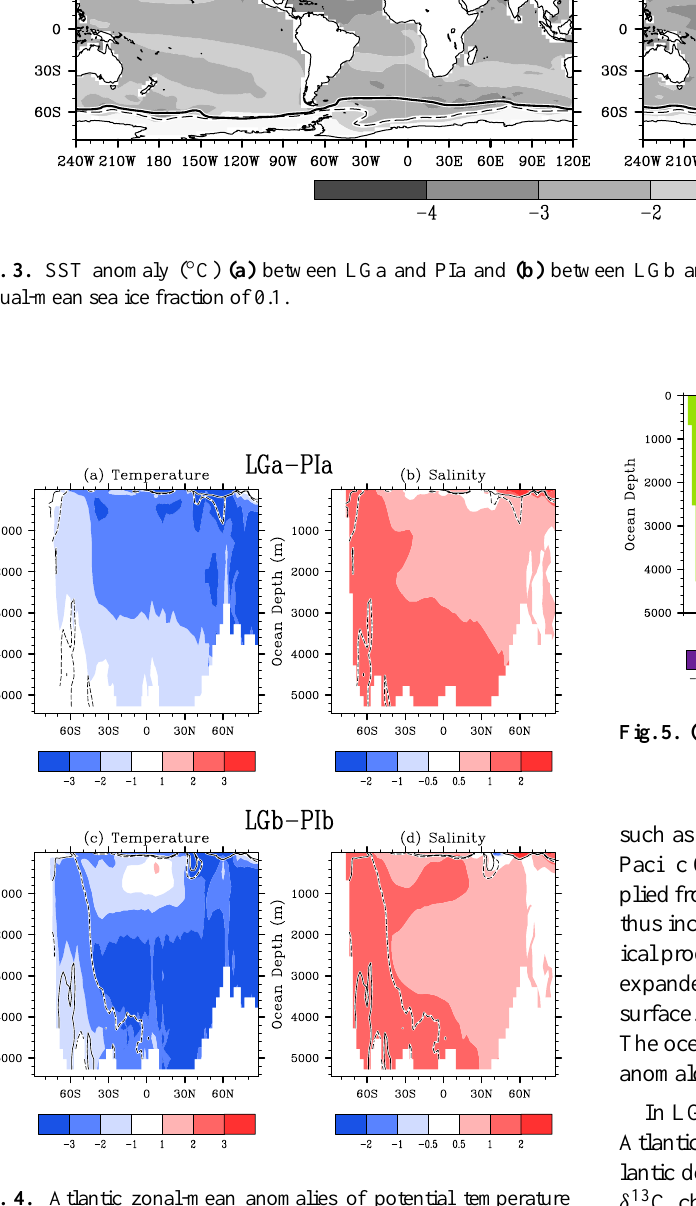
Fig. 4. Atlantic zonal-mean anomalies of potential temperature ( ◦ C) and salinity (psu) (a and b) between LGa and PIa and (c and d) between LGb and PIb. Salinity has been adjusted by 1psu in each glacial AOGCM result to consider freshwater change due to frozen glacial ice sheets. Solid (dashed) lines indicate potential den- sity anomaly of 0.35 (0.25) between each glacial and preindustrial simulations.